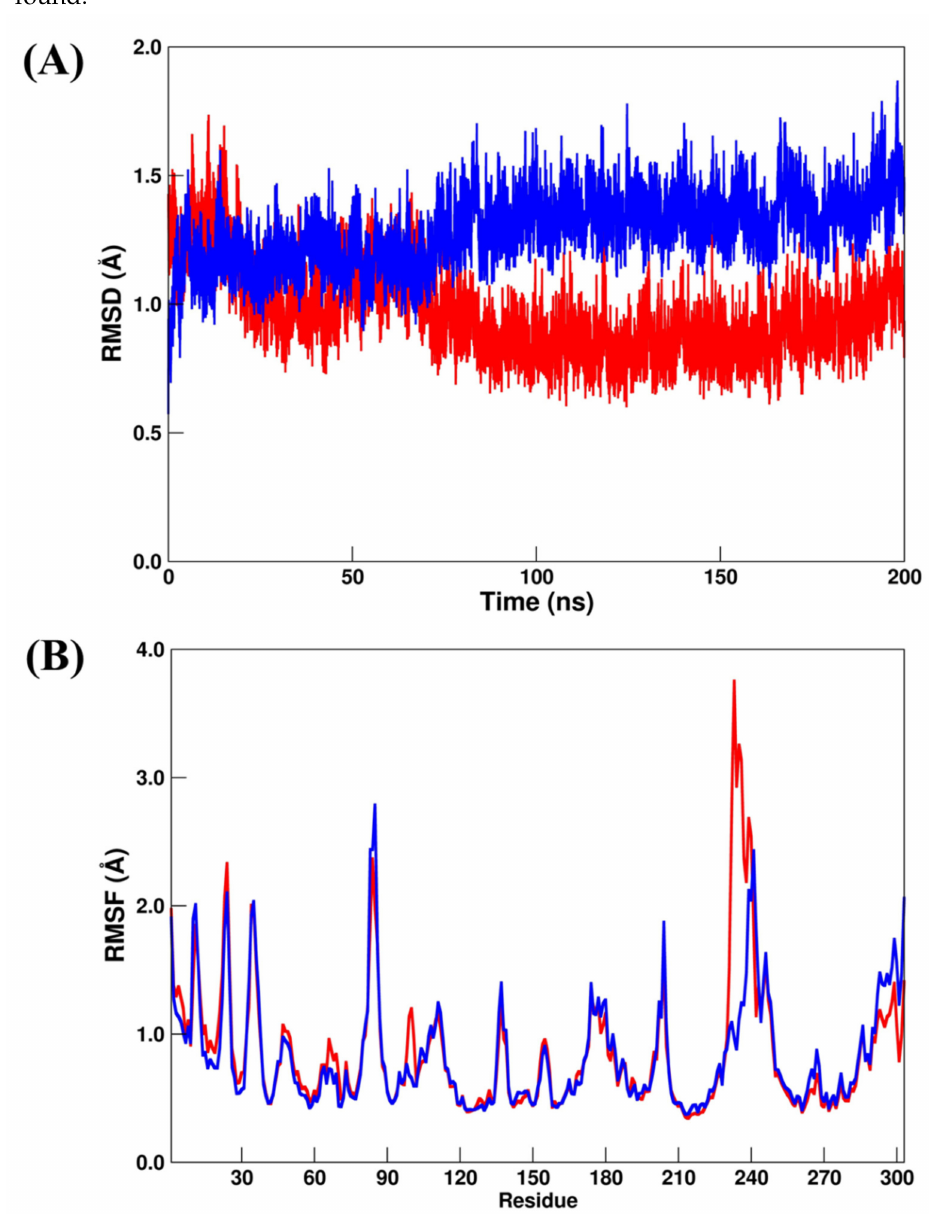
Figure 8. ( A ) RMSD and ( B ) RMSF plots for AAK1–LKB (red line) and AAK1–NIS (blue line). All values are reported in